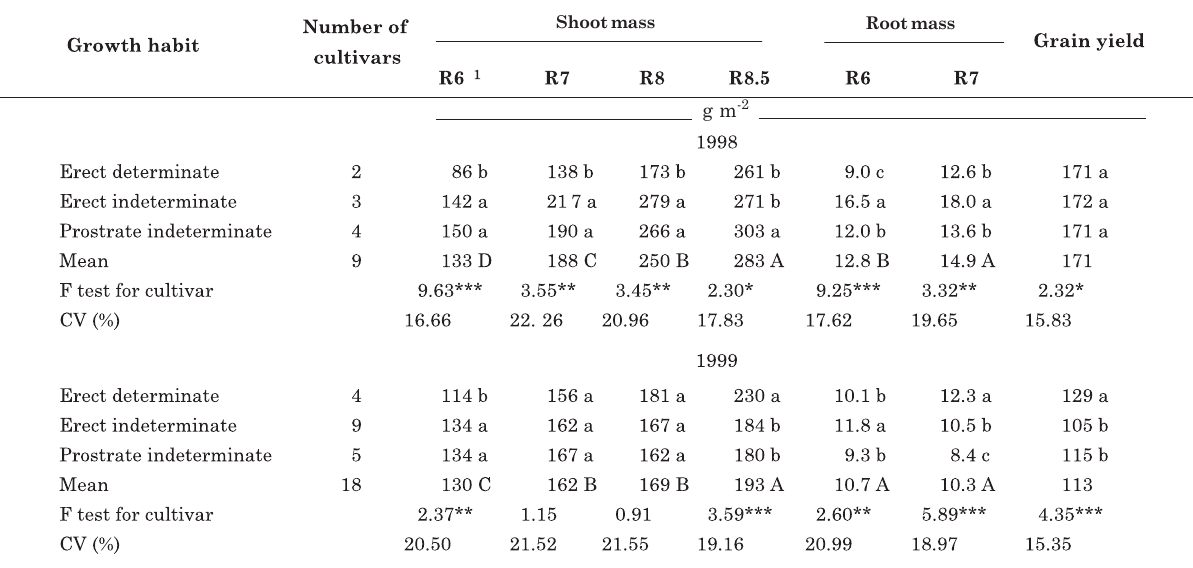
Table 2. Shoot mass at four growth stages, root mass at two growth stages, and grain yield at maturity of common bean cultivars grown in two field experiments (1998 and 1999); cultivars were